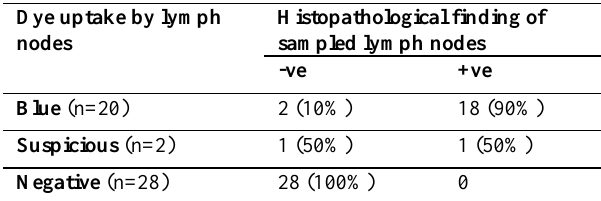
Table 3: Histopathological findings of the lymph node sampling according to dye uptake Dye uptake by lymph